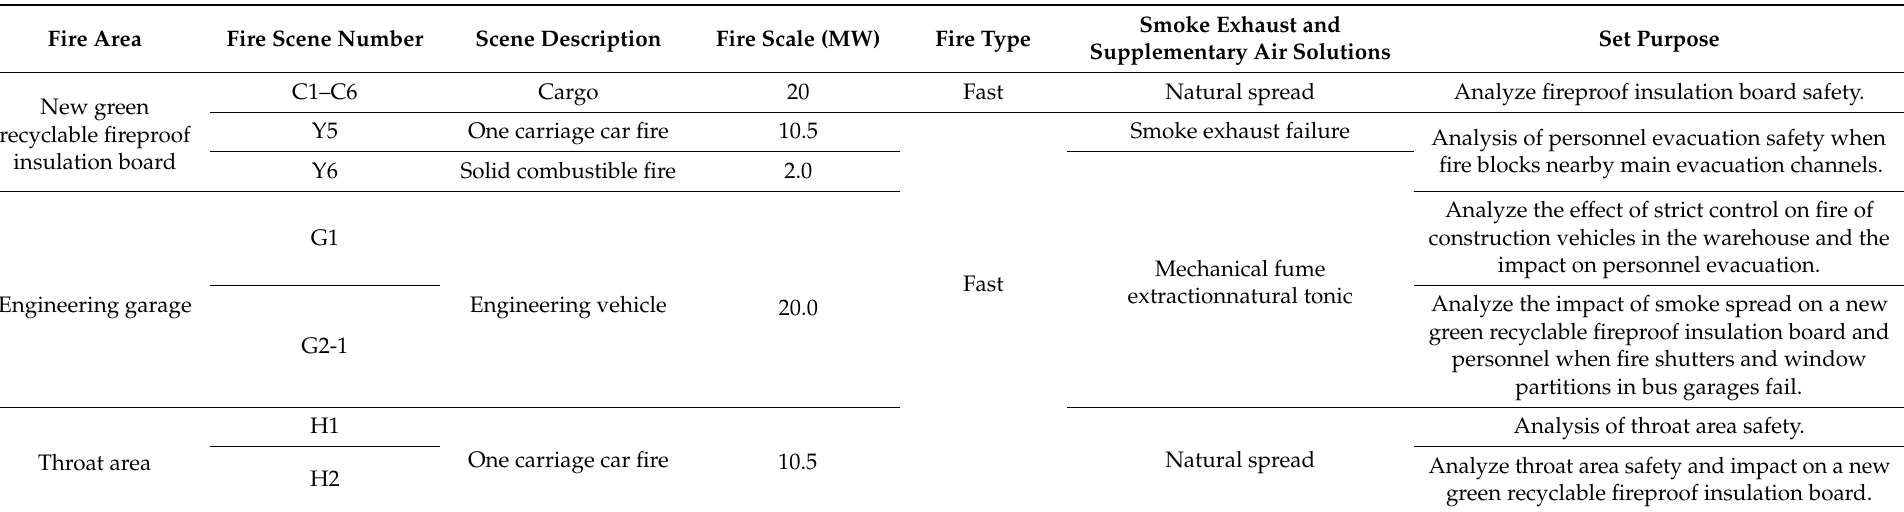
Table 6. Fire scene